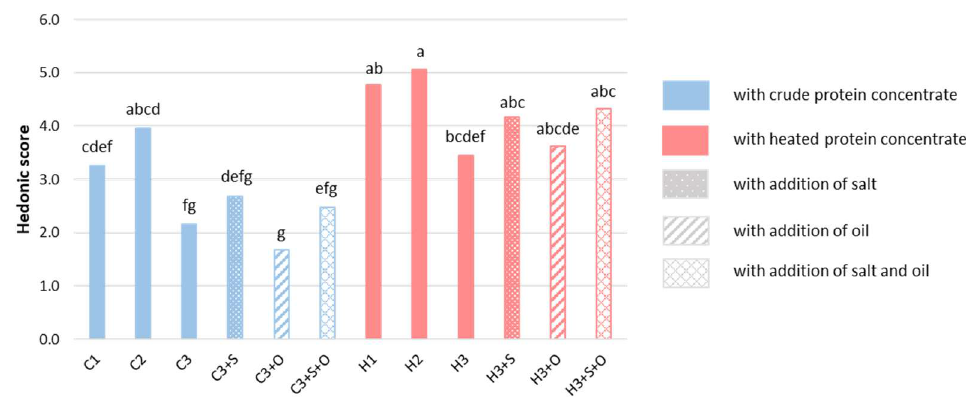
Figure 3. Hedonic score means of the 12 gels (80 consumers). Different letters indicate significant differences considering the same analysis (α = 0.05, Tukey HSD test). The gels are defined in Table